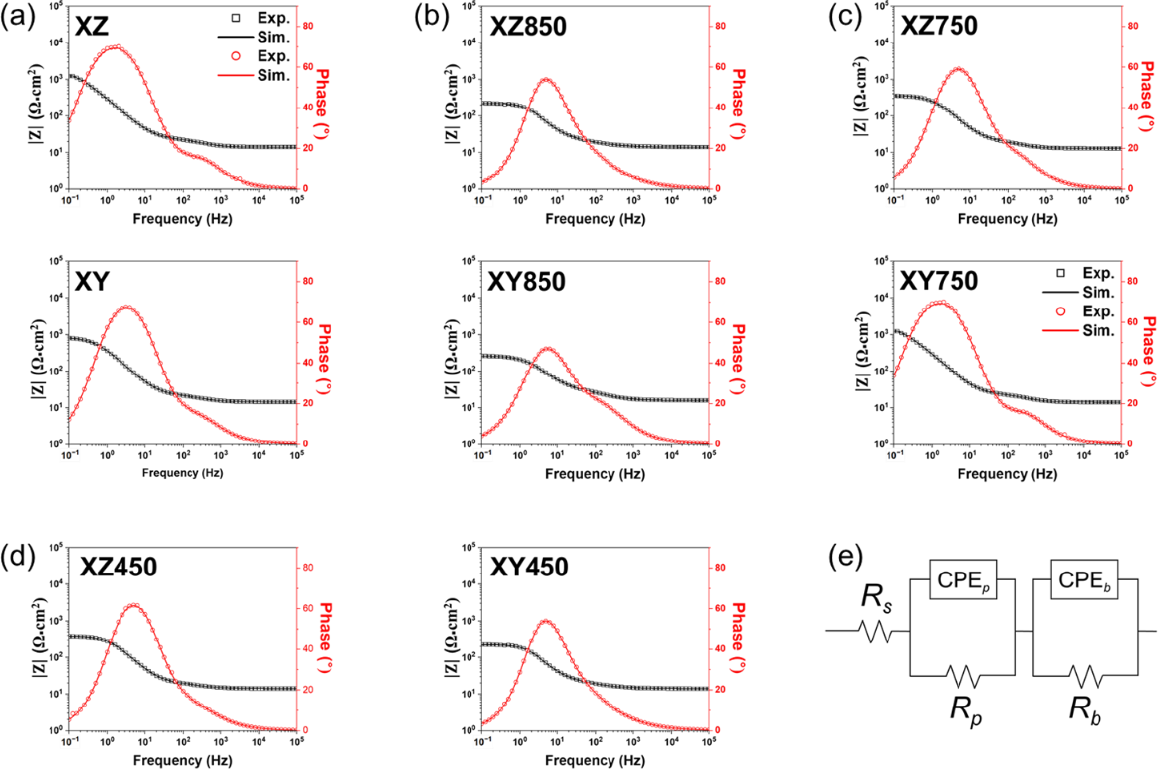
Figure 5. Corrosion resistance of each specimen in 3.5 wt.% NaCl solution: ( a ) potentiodynamic polarization curves of XZ-plane, ( b ) potentiodynamic polarization curves of XY-plane, and ( c ) com- parison of corrosion potential (E corr ) and corrosion current density (i corr ).